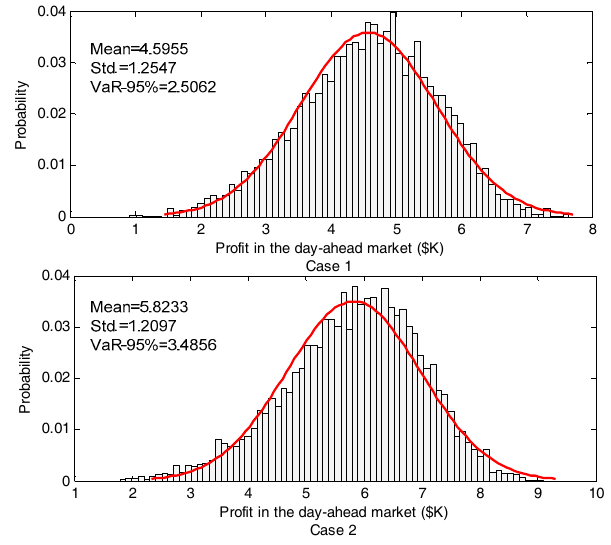
Figure 4. Distributions of the expected profits in the DA market for Cases 1 and 2.